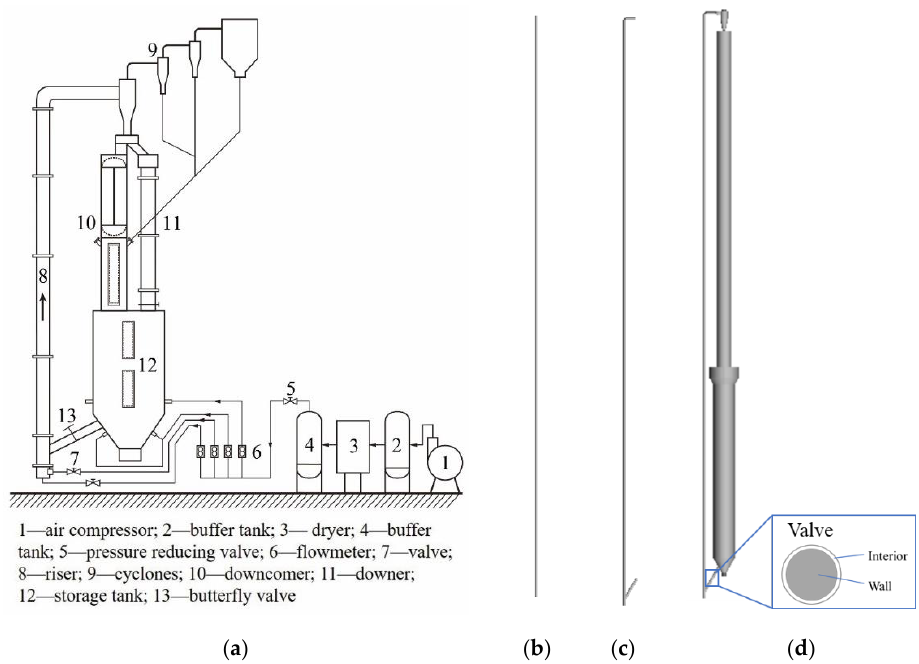
Figure 2. Geometry of the simulation object. ( a ) Experiment CFB setup, ( b ) geometry of riser-simplified simulation, ( c ) geometry of riser-only simulation, ( d ) geometry of full-loop simulation. Table 1. Material properties and operating conditions.